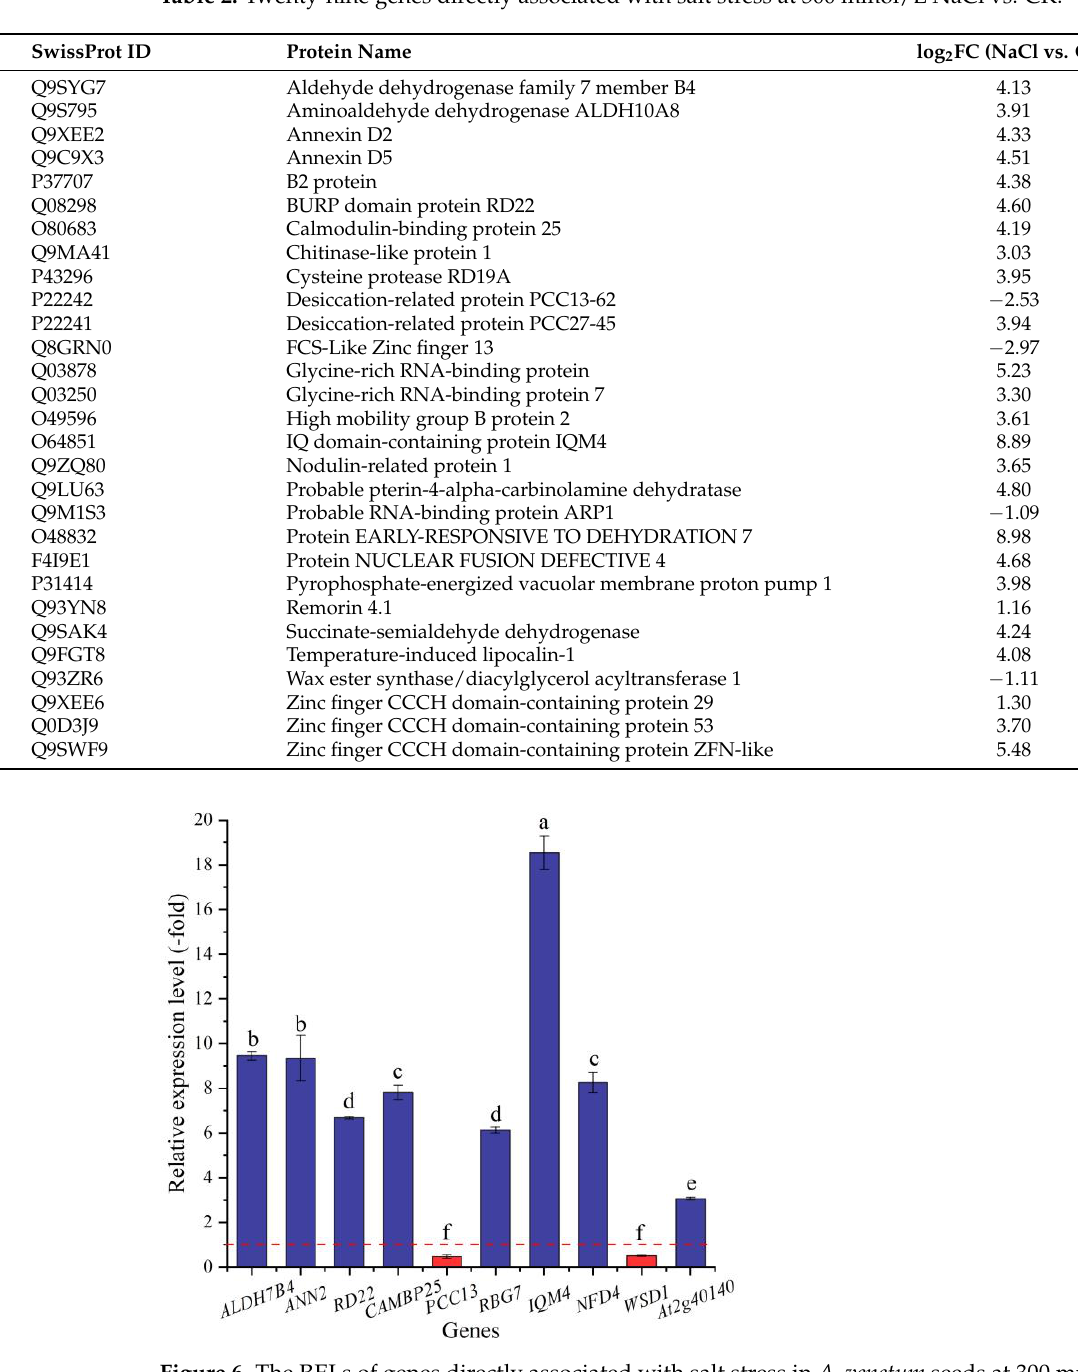
Figure 6. The RELs of genes directly associated with salt stress in A. venetum seeds at 300 mmol/L NaCl vs. CK (mean ± SD, n = 3). Different letters represent a significant difference ( p < 0.05) among different genes. The red dotted line differentiates UR (>1) and DR (<1).